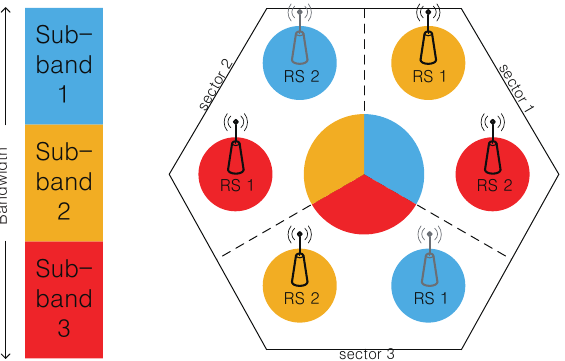
Figure 2. Orthogonal frequency allocation with two RSs per sector.